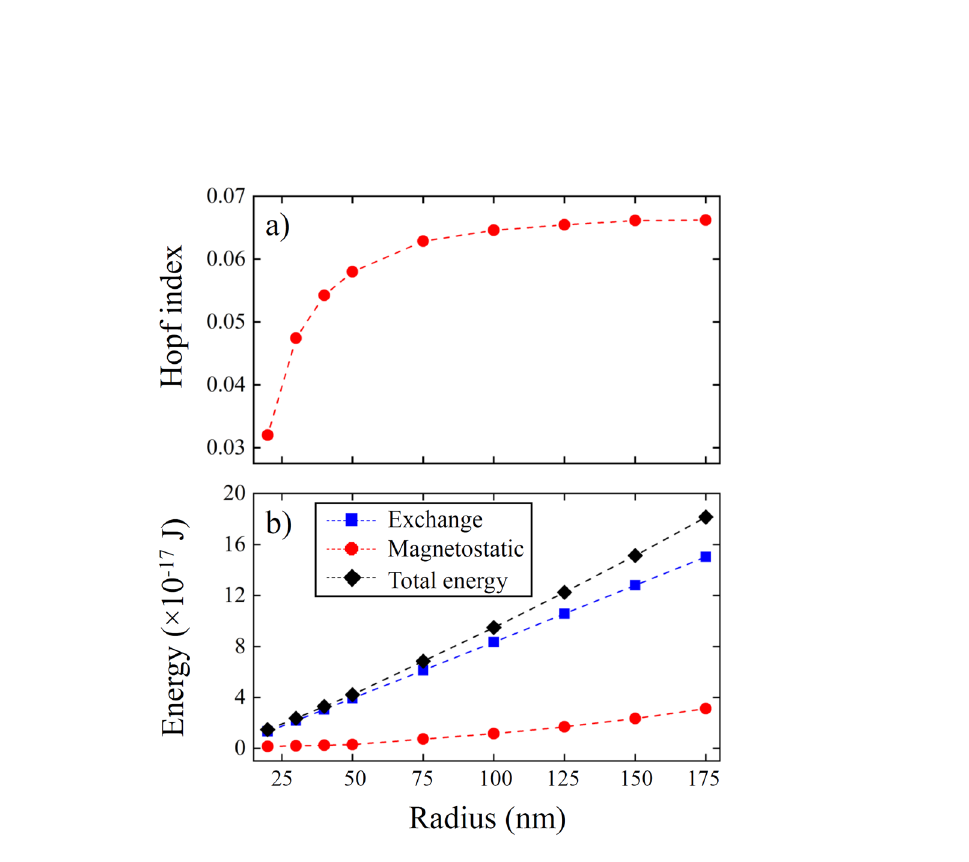
Figure 4. Hopf index and magnetic energy of a Bloch point. The calculated Hopf index (a) and the energy (b) of a Bloch point in a spherical magnetic nanoparticle as function of the particle radius R